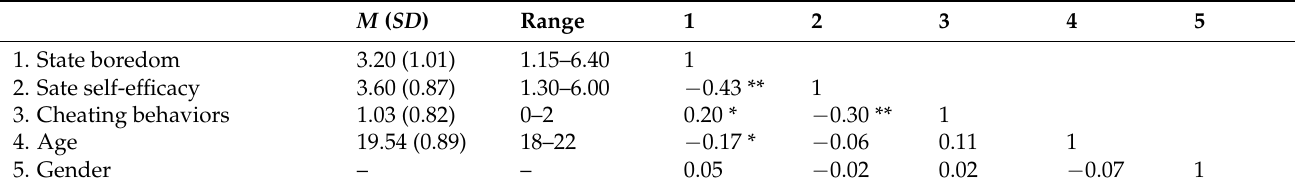
Table 3. Pearson’s correlations of all variables in Study 2 ( N = 139).